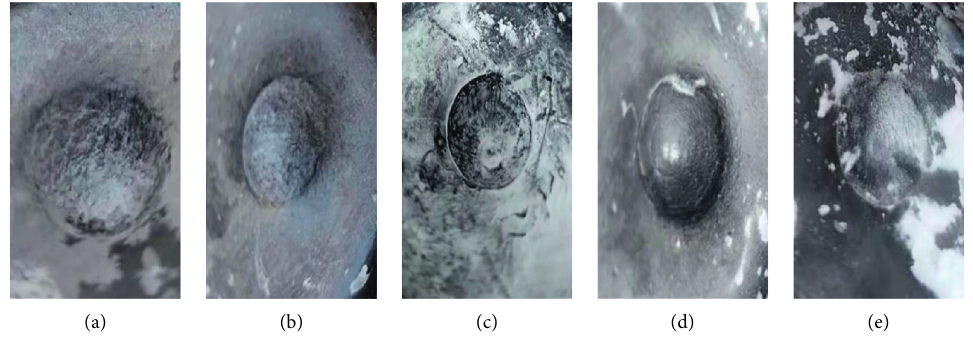
Figure 9: AR binders with #20–80 CR in the experimental procedure for resilience at 180 ° C. (a) AR with #20 CR, (b) AR with #30 CR, (c) AR with #40 CR, (d) AR with #60 CR, and (e) AR with #80